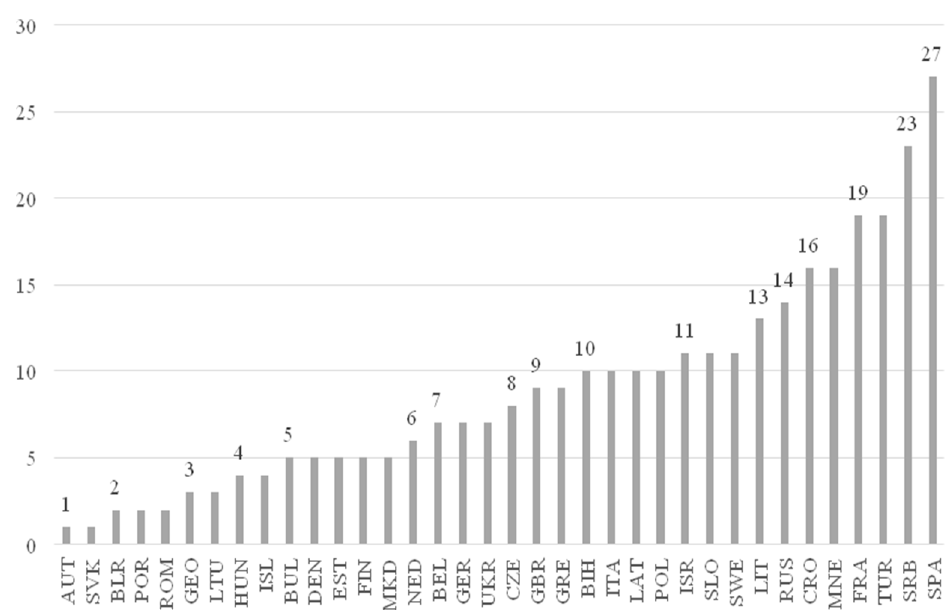
Figure 1. Number of players selected from nations ( n = 320) (figure by the authors).